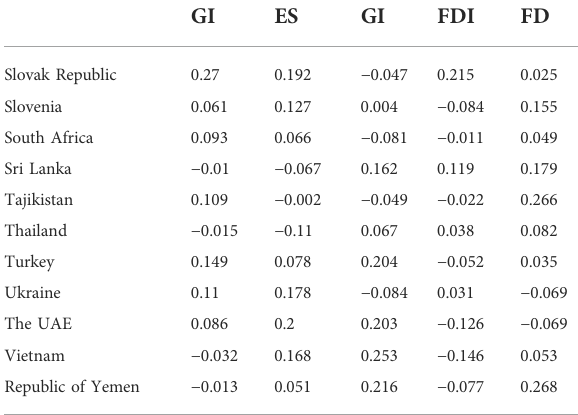
TABLE 8 Results of country-wise DOLS